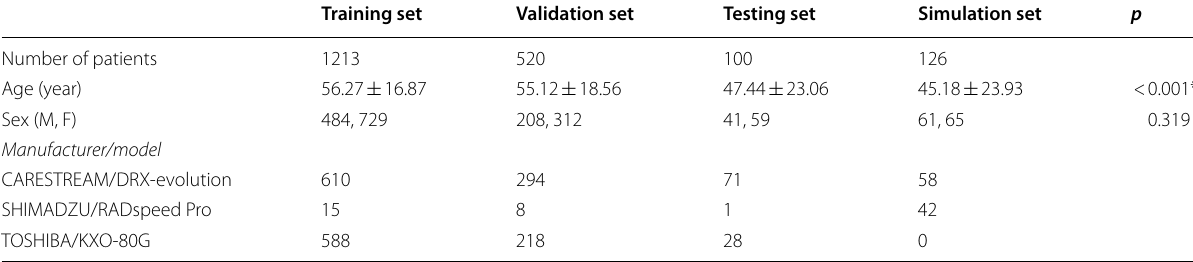
Table 1 Demographic data of patients included in the training, validation, testing, and simulation